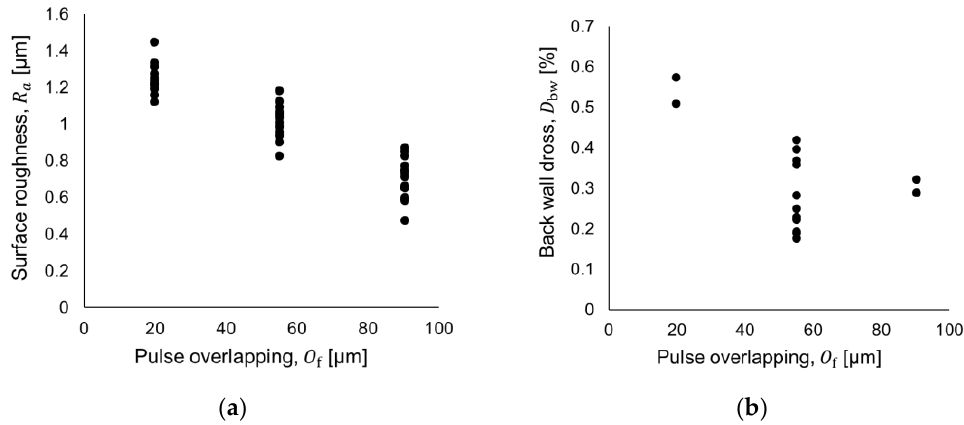
Figure 5. Illustration of variability in the process: ( a ) surface roughness and ( b ) back-wall dross (Tube A OD = 3.0 mm & t = 0.22 mm).